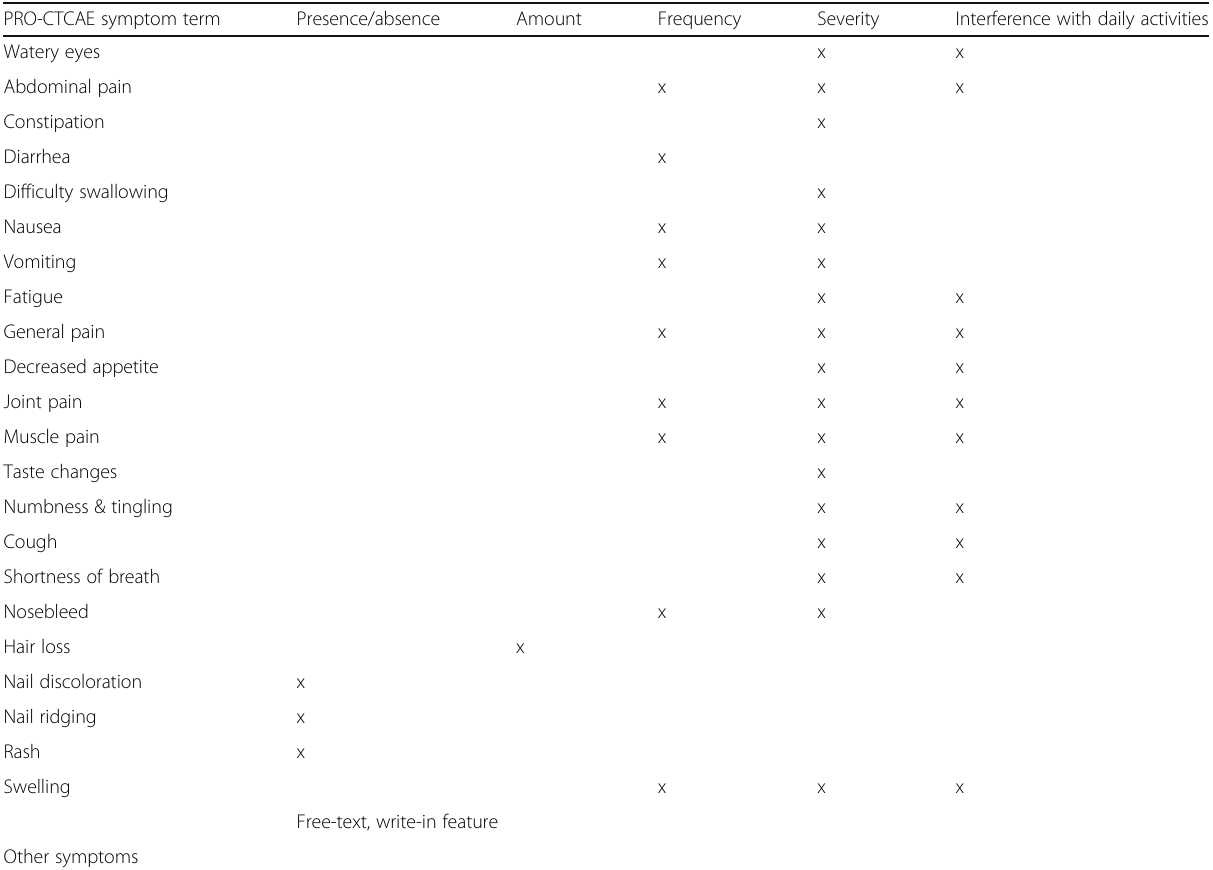
Table 1 Twenty-two PRO-CTCAE symptom terms (41 items) and a write-in text box PRO-CTCAE symptom